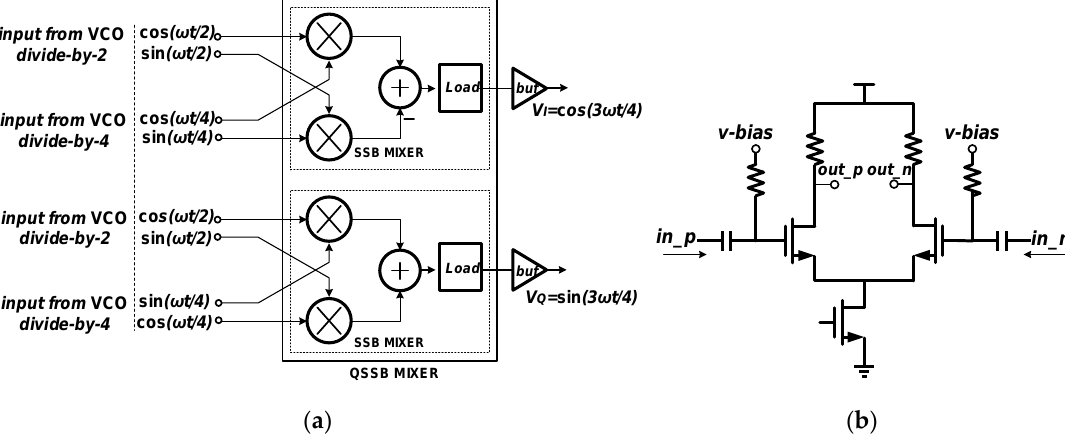
Figure 9. ( a ) The overall quadrature single side-band (QSSB) mixer structure; ( b ) the output